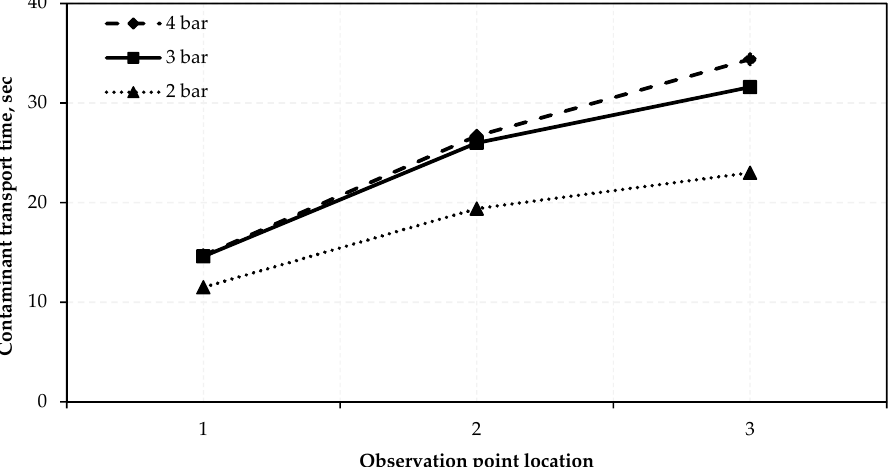
Figure 5. Time required for a 40 mL / L contaminant concentration to reach observation points 1, 2, and 3 located at (168, 138), (140, 37) and (50, 143), respectively.